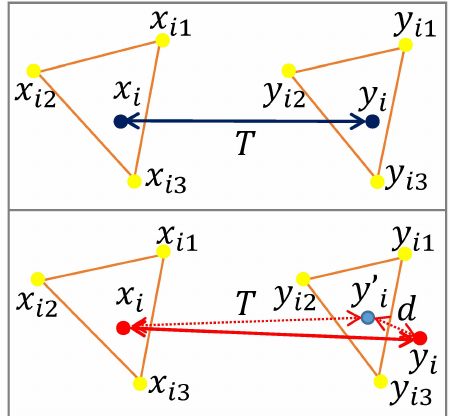
Figure 5. Schematic diagram of our affine transformation constraint. The affine transformation model T constructed by the neighborhood points of the correct matching points will result in a small or zero symmetry transition error d ( above ). Conversely, mismatched points will bring about a larger symmetrical transfer error d ( below ).